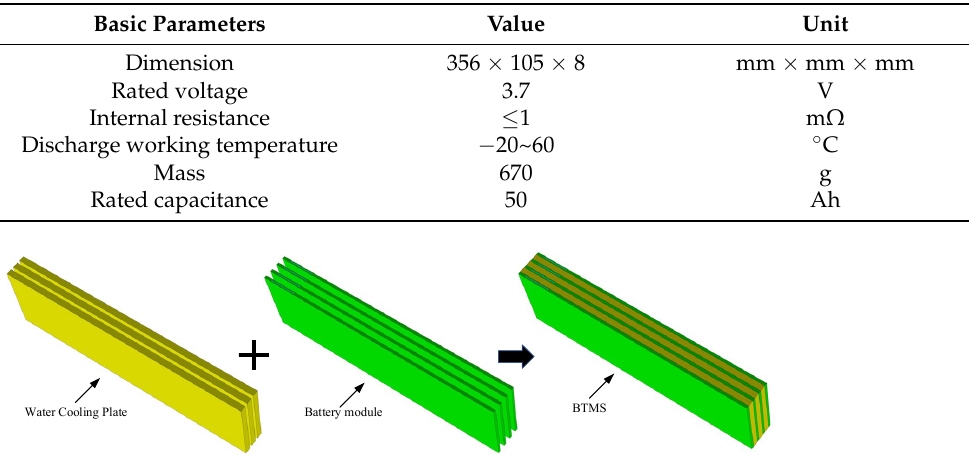
Figure 2. The water-cooling BTMS geometric structure.